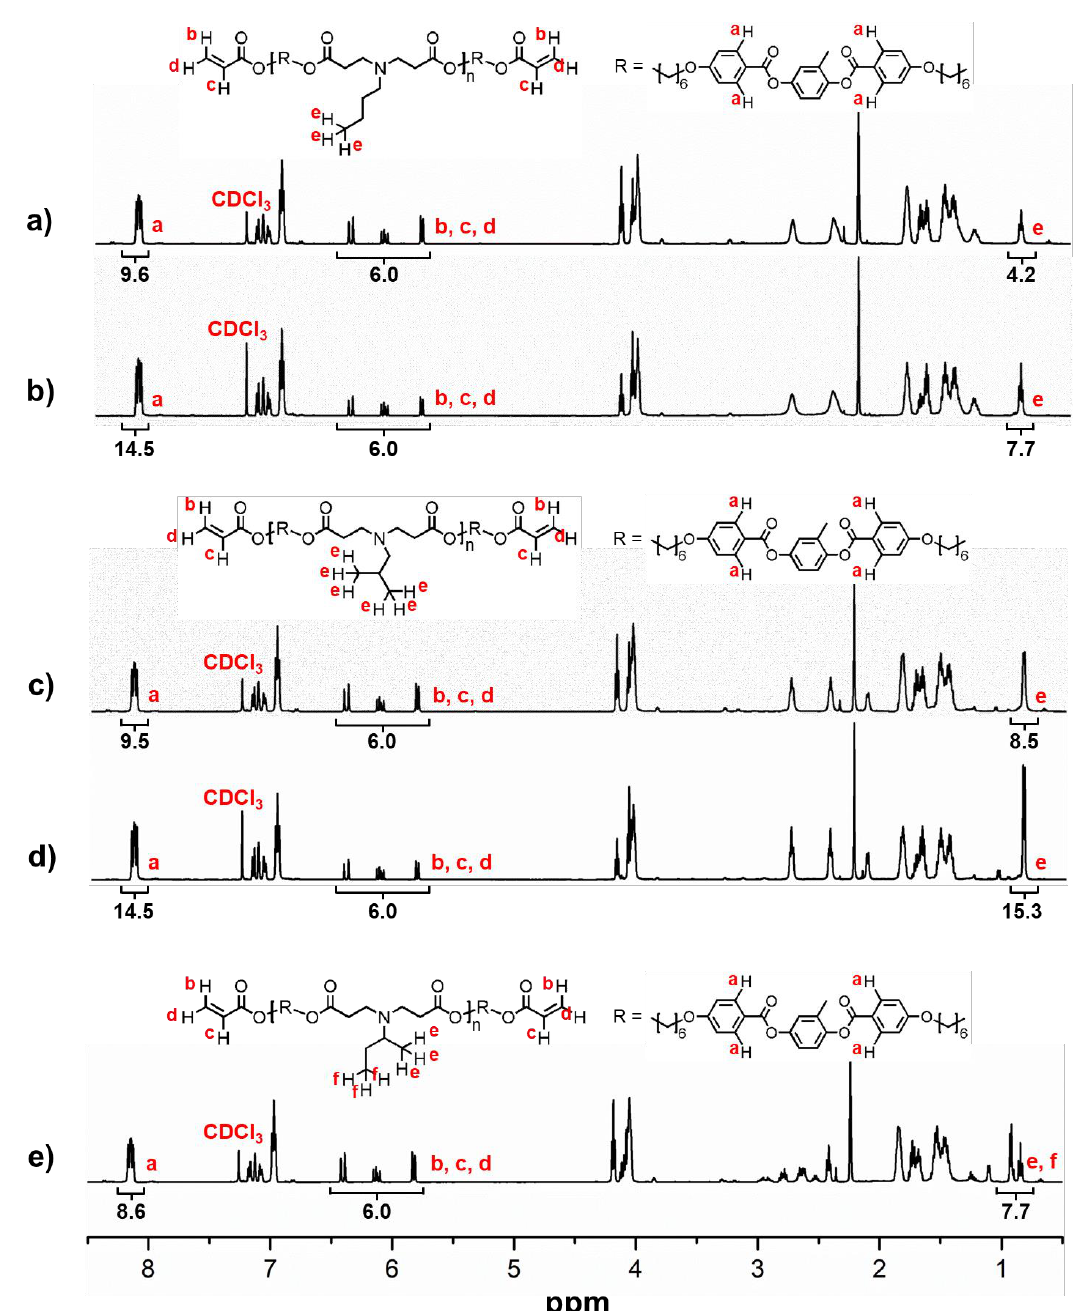
Figure 2. 1 H NMR spectra of LC oligomers (LCOs) in CDCl 3 : ( a ) LCO-N1, ( b ) LCO-N2, ( c ) LCO-I1, ( d ) LCO-I2, and ( e ) LCO-S1. The protons used for calculating the degree of polymerization (DP) of the LCOs are marked in red.